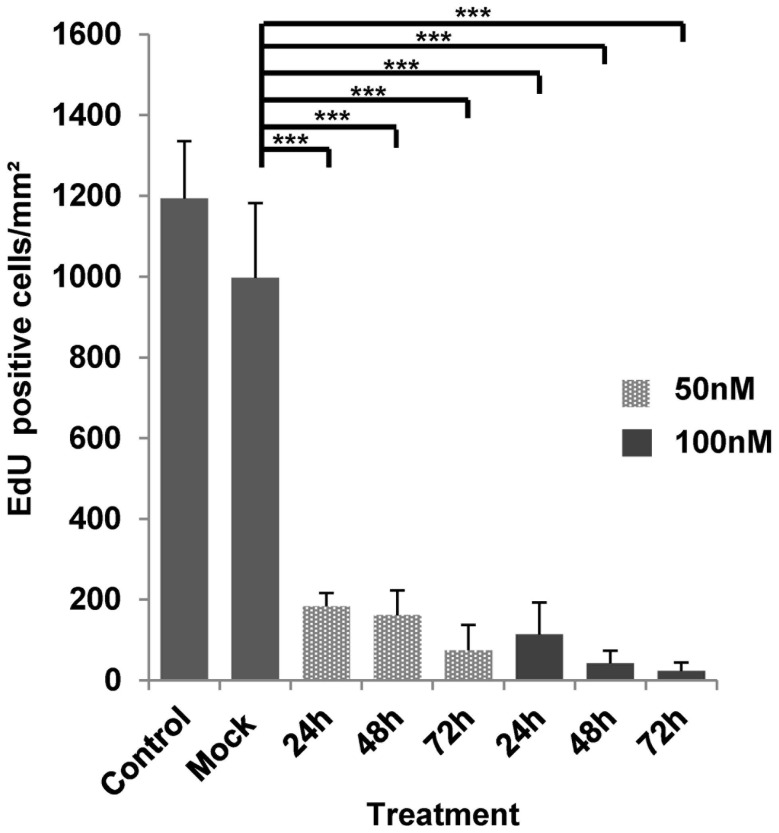
Short-term treatment of metacestode vesicles with BI 2536.Metacestode vesicles were treated for 24, 48 or 72(as indicated) with 50 nM (light grey) or 100 nM (dark grey) of BI 2536, followed by one day of recovery without inhibitor. EdU labeling (5 h, 50 µM EdU) was carried out and labeled cells were microscopically counted. Shown are EdU-positive cell counts per mm2 of GL. ‘Control’ indicates vesicles cultivated in A4 medium alone. ‘Mock’ indicates the DMSO control. ***(p<0.001) (Student's t-test).